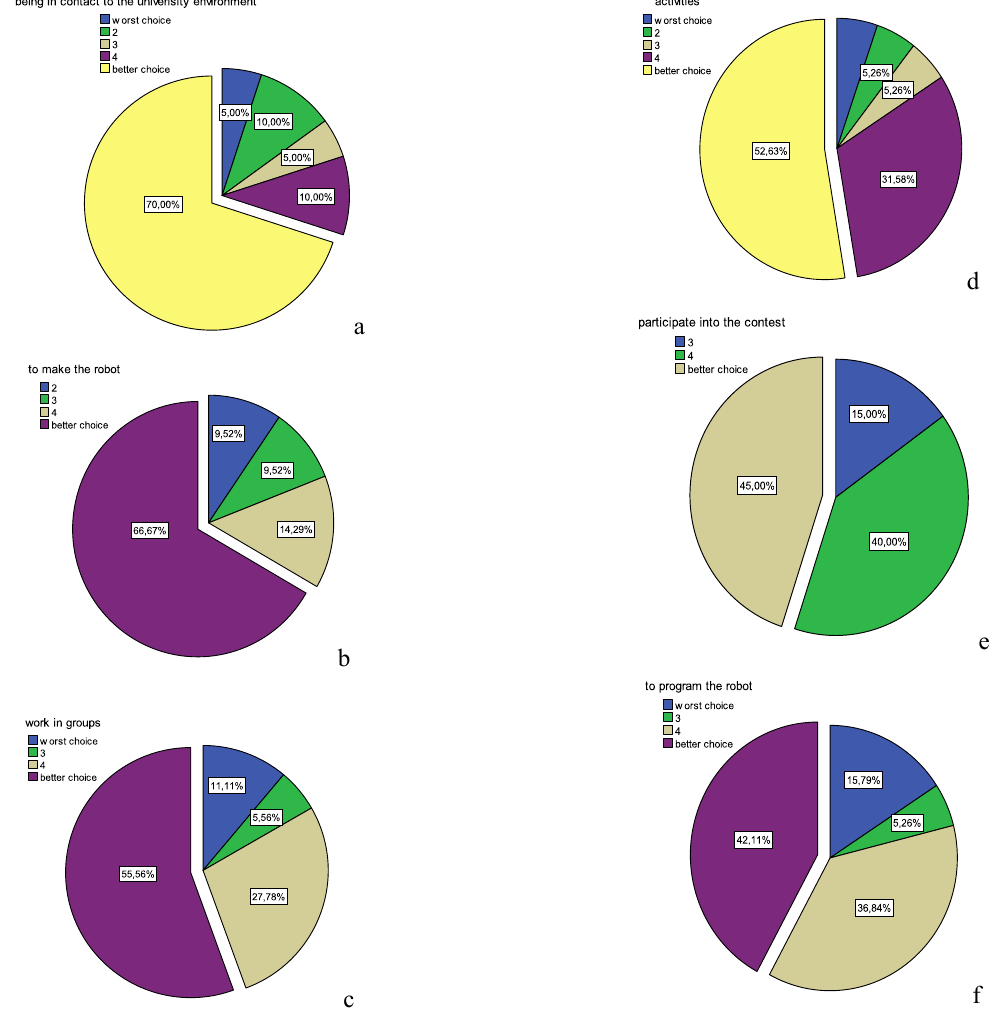
Figure 4. Obtained results to the question “identify what do you like most in the robotparty” (a) being in contact to the university environment, (b) to make the robot, (c) work in groups, (d) activities, (e) participate into the contest, (f) to program the robot.